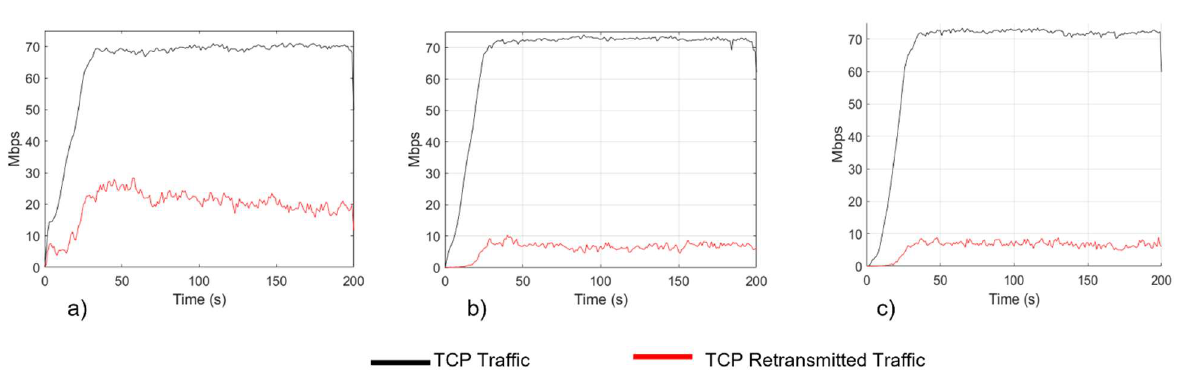
Figure 9. Evaluation of the path capacity using TCP traffic. The paths were selected according to the following multi-objective methods: ( a ) w B , D , PL (weighted sum), ( b ) Min f MOEA/D.